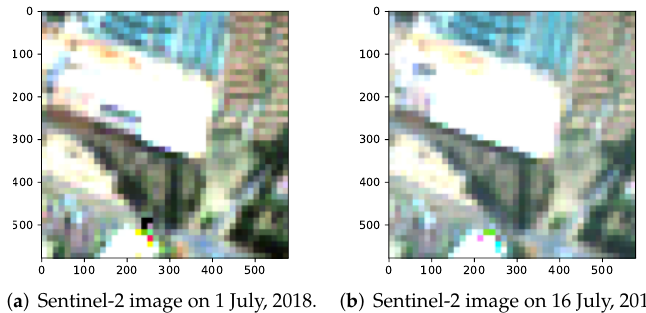
Figure 9. Sentinel-2 images of a true-positive blob at a Thornhill Estates construction